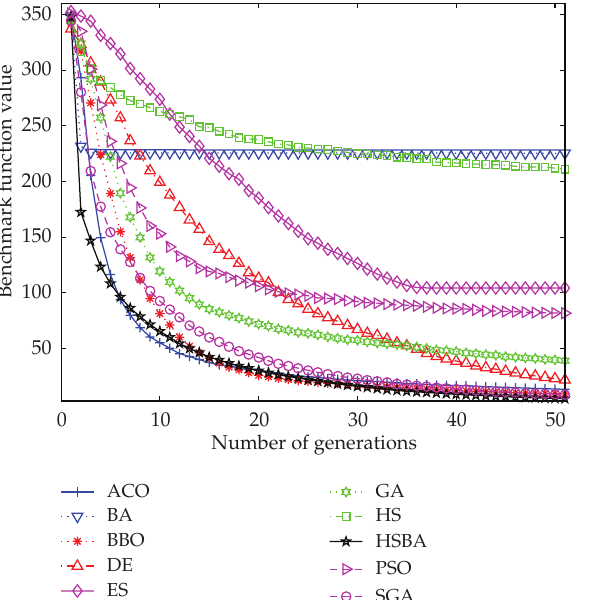
Figure 3: Comparison of the performance of the different methods for the F03 Griewank function.